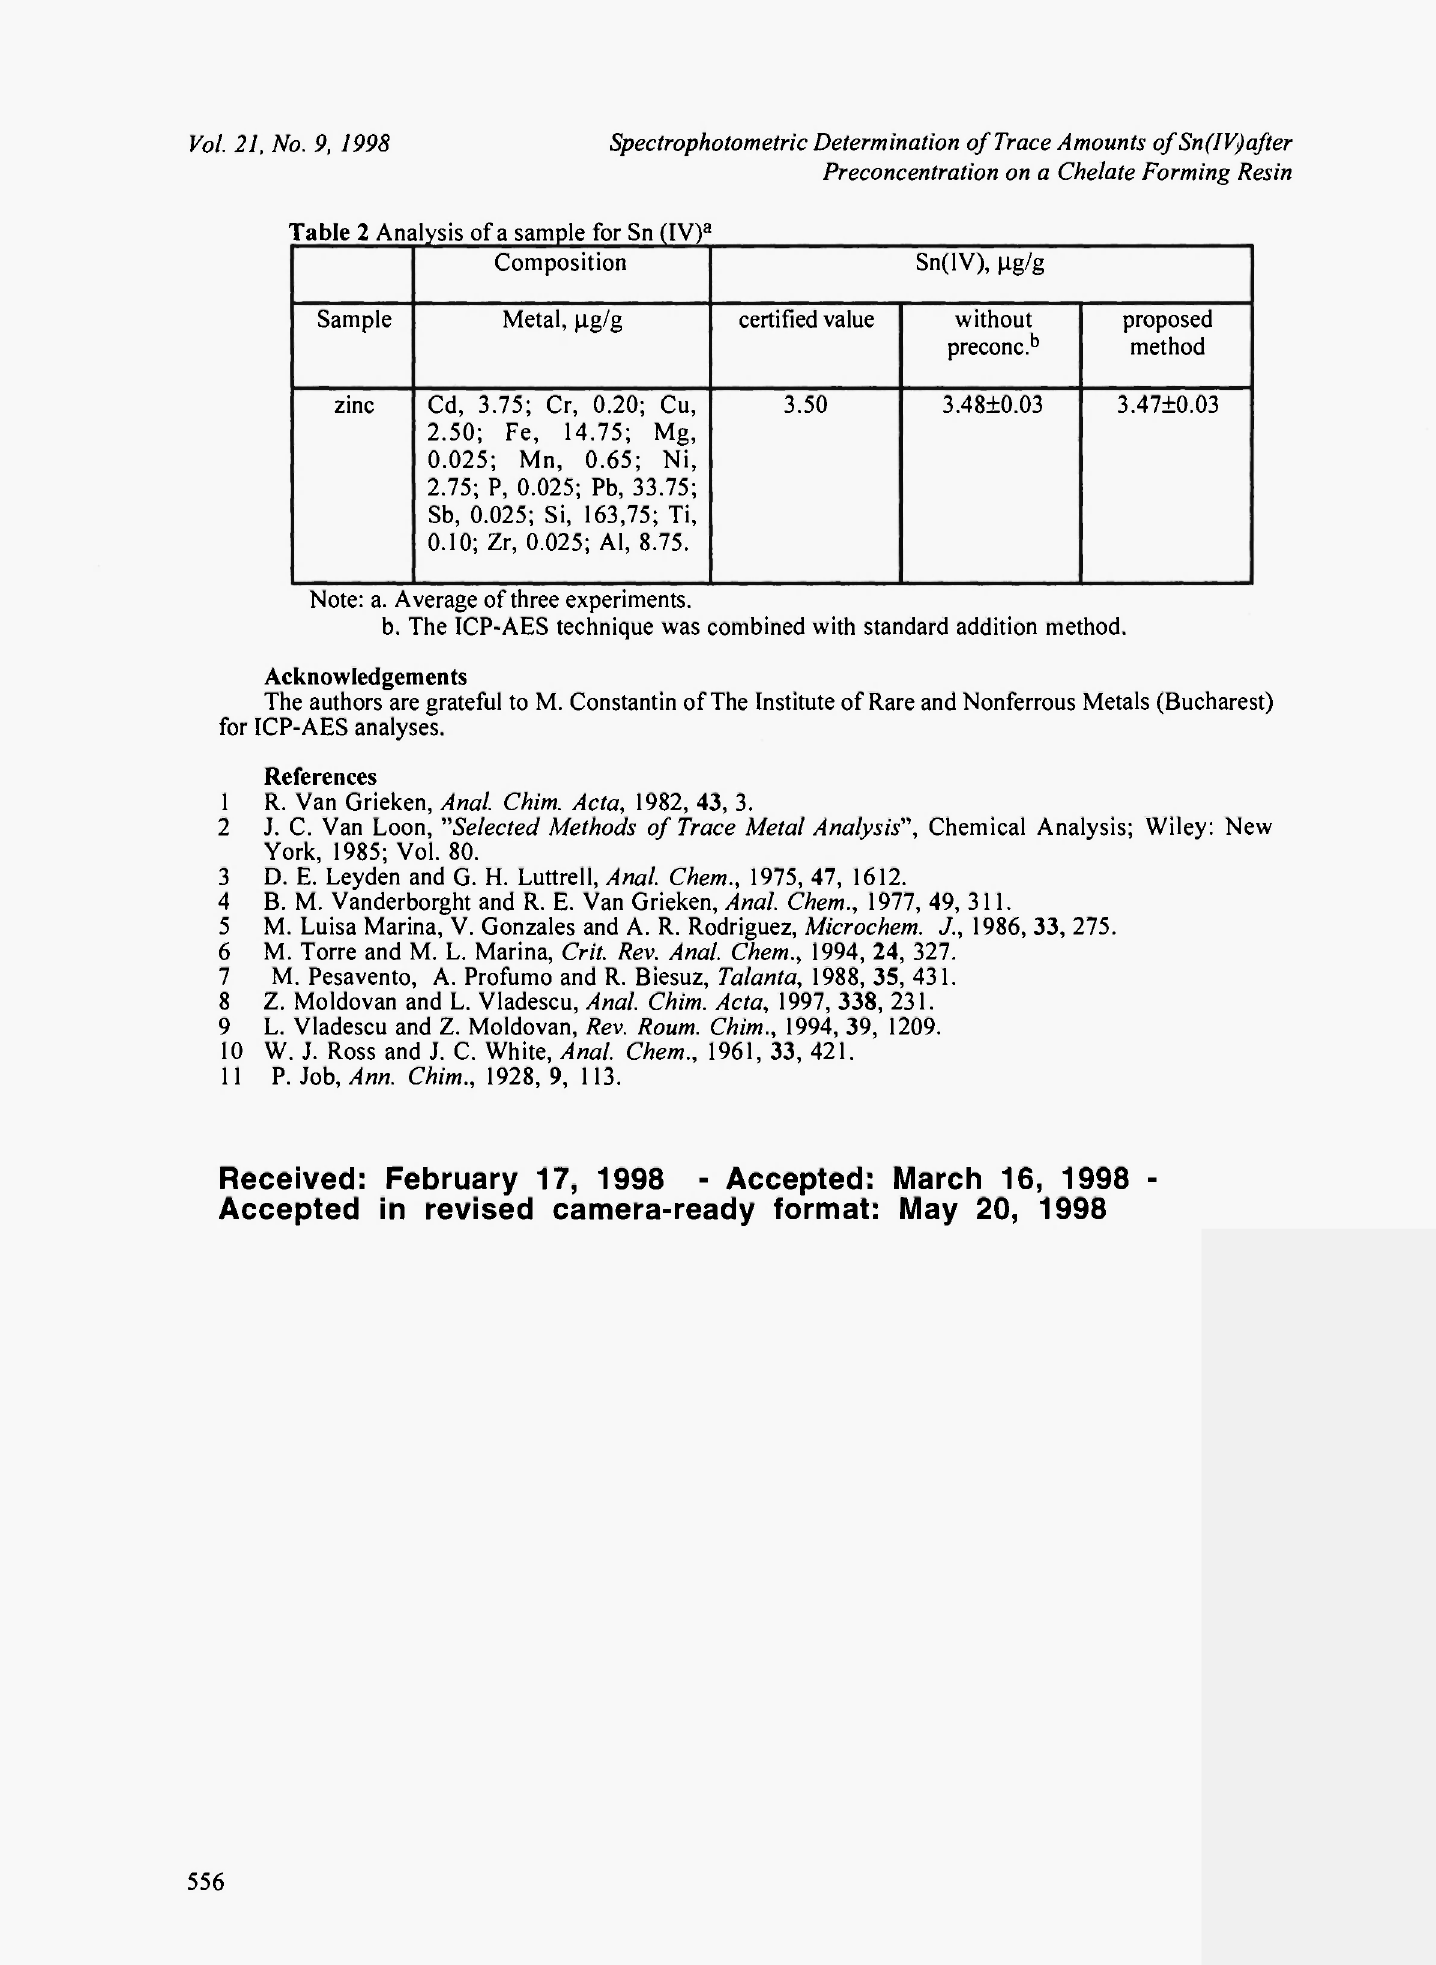
Table 2 Analysis of a sample for Sn (IV) a